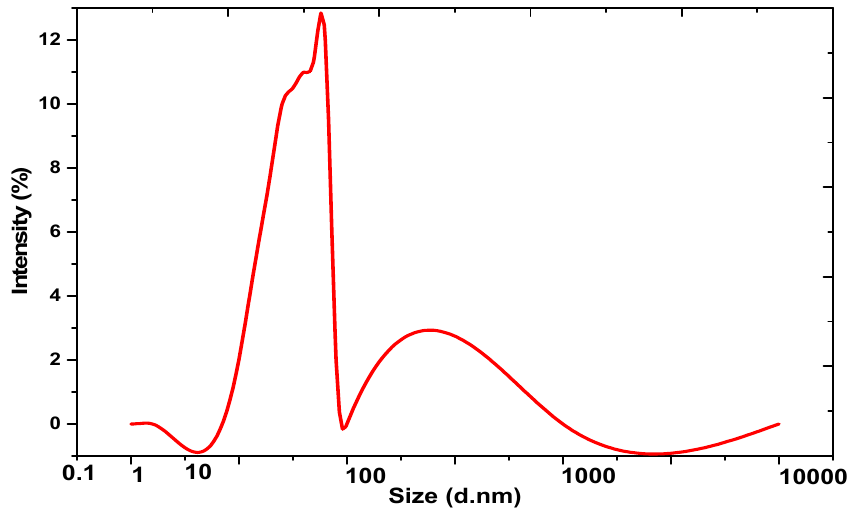
Figure 2. Particle size distribution of the OPS